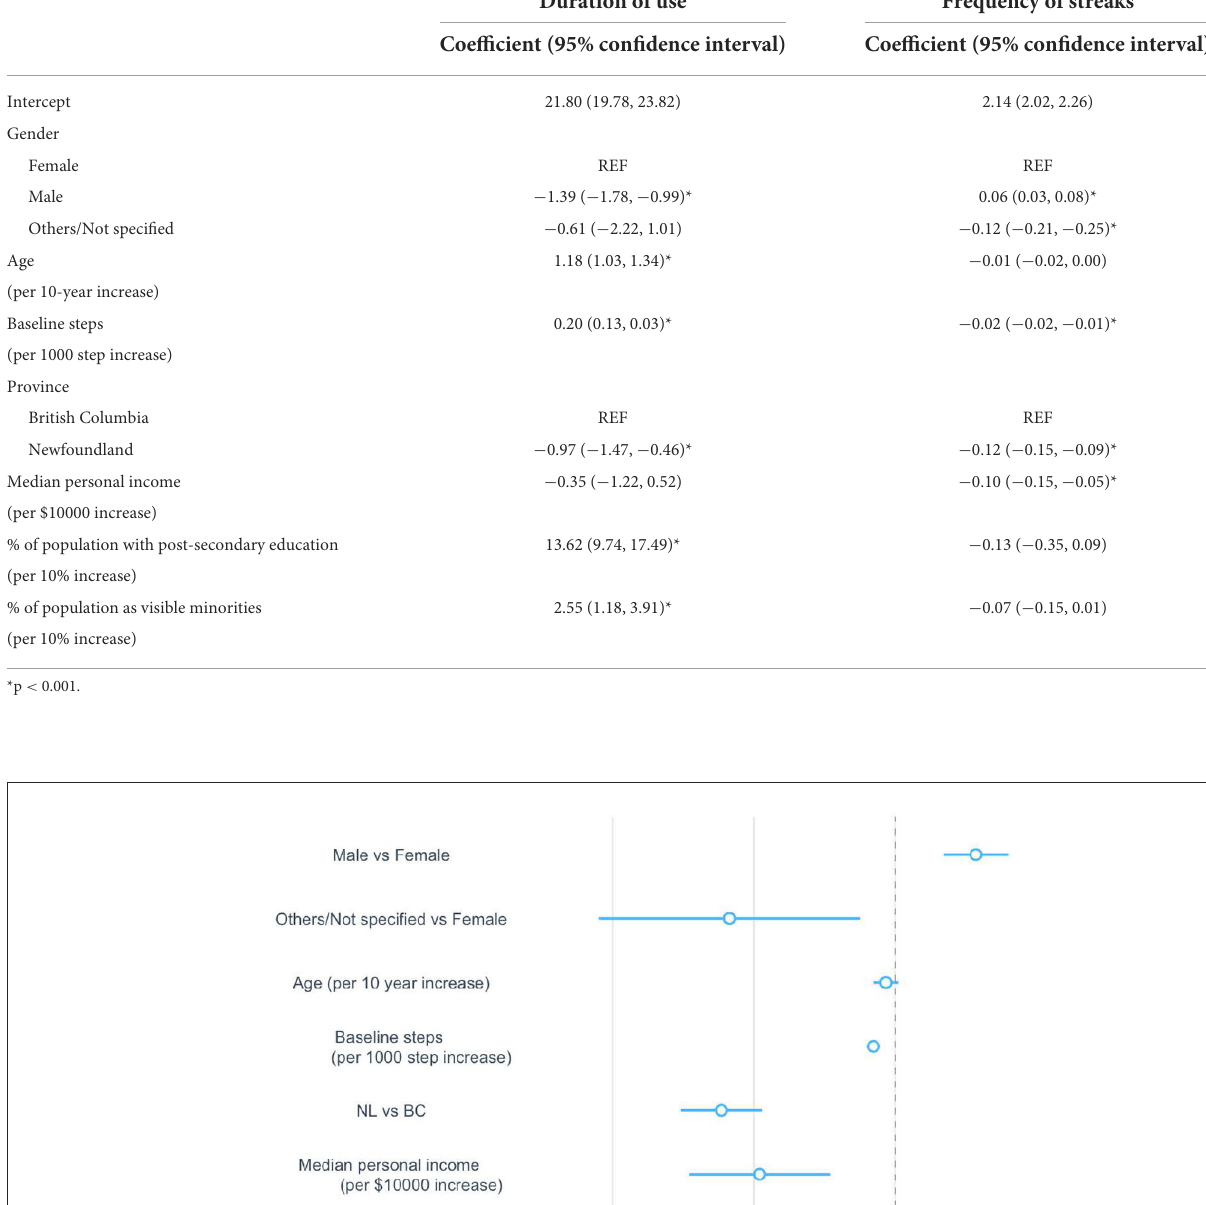
TABLE 2 Regression coefficients for sociodemographic correlates associated with duration of use and frequency of streaks.